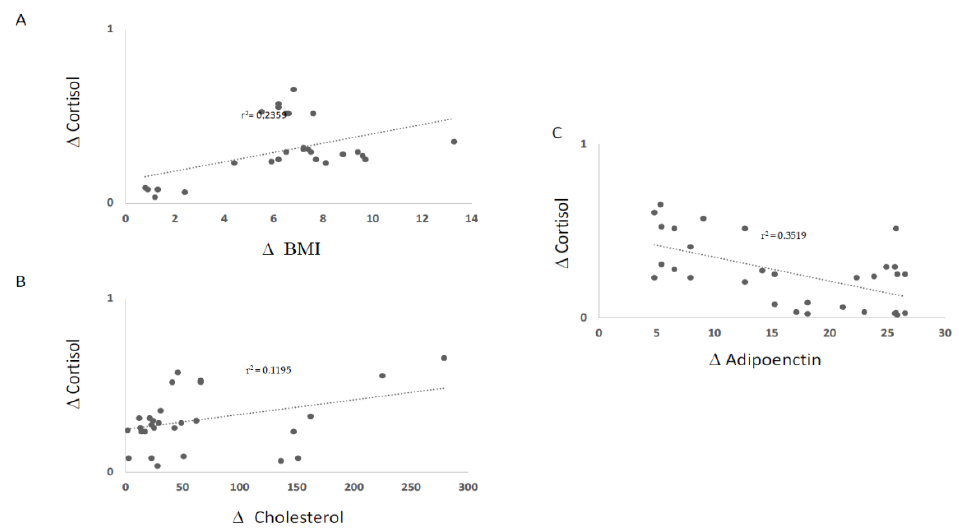
Figure 3. Salivary cortisol concentrations correlated negatively with BMI and total cholesterol ( A ) and ( B ); and positively correlated with adiponectin ( C ). ( Δ) indicates the variation between T1 and T0 in the VLCKD obese subjects for each